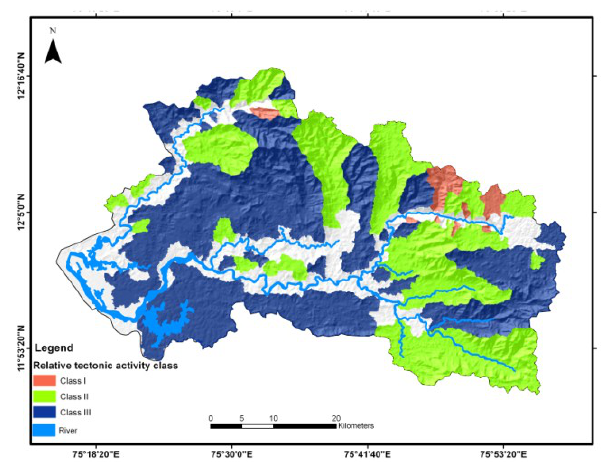
Figure 7. Relative tectonic activity